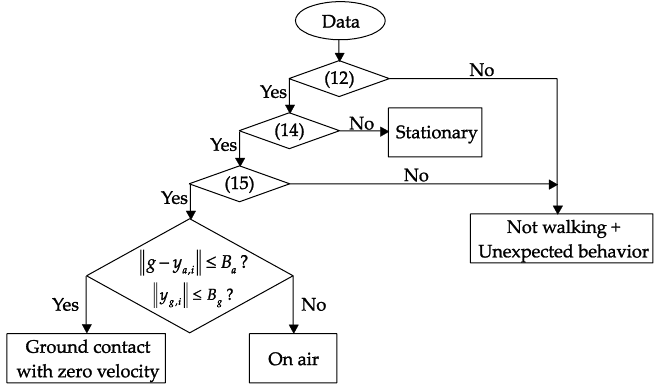
Figure 12. Flowchart of walking phase classification for a quadripod cane.